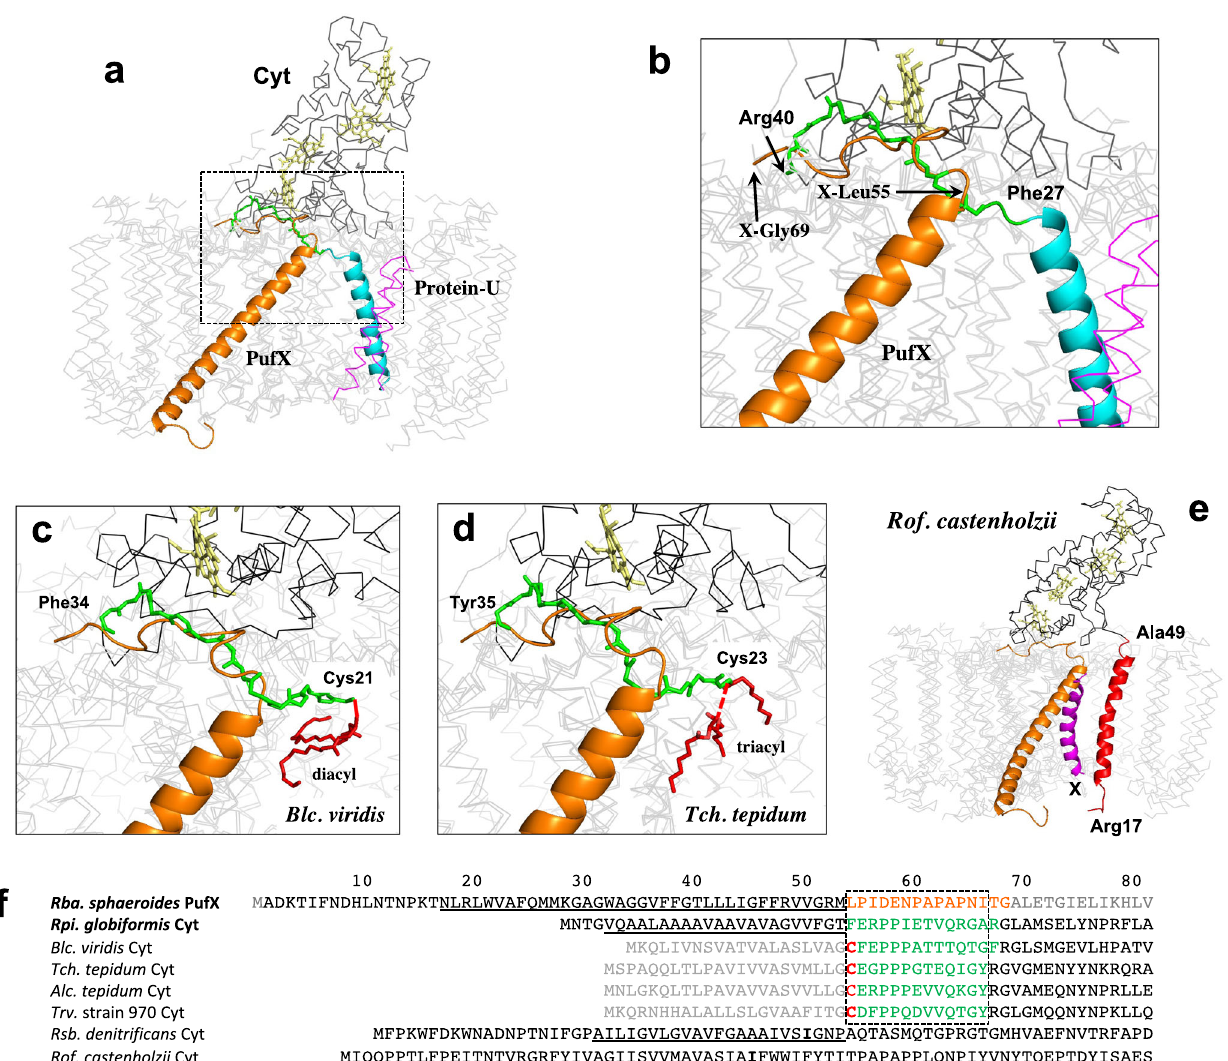
Fig. 3 Structural similarities between PufX and the N-termini of the RC-bound Cyt subunits. a Superposition of the C α carbons of the RC-M subunits between the Rba. sphaeroides monomeric LH1 – RC (PDB: 7F0L) and Rpi. globiformis RC (this work). PufX is shown as orange cartoon. The transmembrane helix and the following loop region of the Cyt subunit are shown by cyan cartoon and green sticks (main chain only), respectively. The other portion of the Cyt subunit is shown by a black ribbon and heme groups are shown by pale yellow sticks. Protein-U in Rba. sphaeroides LH1 – RC is shown by magenta ribbon. b Expanded view marked in a showing that the C-terminus (Leu55 – Gly69) of PufX overlaps positionally and conformationally with the N-terminal loop region (Phe27 – Arg40, colored green) of the Rpi. globiformis Cyt subunit. c Similar comparison between the C-terminus of Rba. sphaeroides PufX and the N-terminus (Cys21 – Phe34, colored green) of Blc. viridis Cyt subunit (PDB: 3T6E). d Similar comparison between the C-terminus of Rba. sphaeroides PufX and the N-terminus (Cys23 – Tyr35, colored green) of Tch. tepidum Cyt subunit (PDB: 5Y5S). e Comparison of the Rba. sphaeroides PufX with the N-terminal transmembrane domain (Arg17 – Ala49, red cartoon) of Rof . castenholzii Cyt subunit in an LH – RC structure (PDB: 5YQ7). A hypothetical subunit X is shown by magenta cartoon. f Sequence alignments of Rba. sphaeroides PufX (from strain IL106) with the N-termini of the Cyt subunits from other phototrophs based on the residues in the loop regions marked by dashed box or the transmembrane domains. Residues in the C-terminus (Leu55 – Gly69) of PufX are shown by orange fonts. Residues truncated by posttranslational modi fi cation are shown by gray fonts. The Cys residues that bind a triacyl or diacyl group are shown by red fonts. Residues with green fonts correspond to the N-terminal portions shown in a – d . Transmembrane regions are